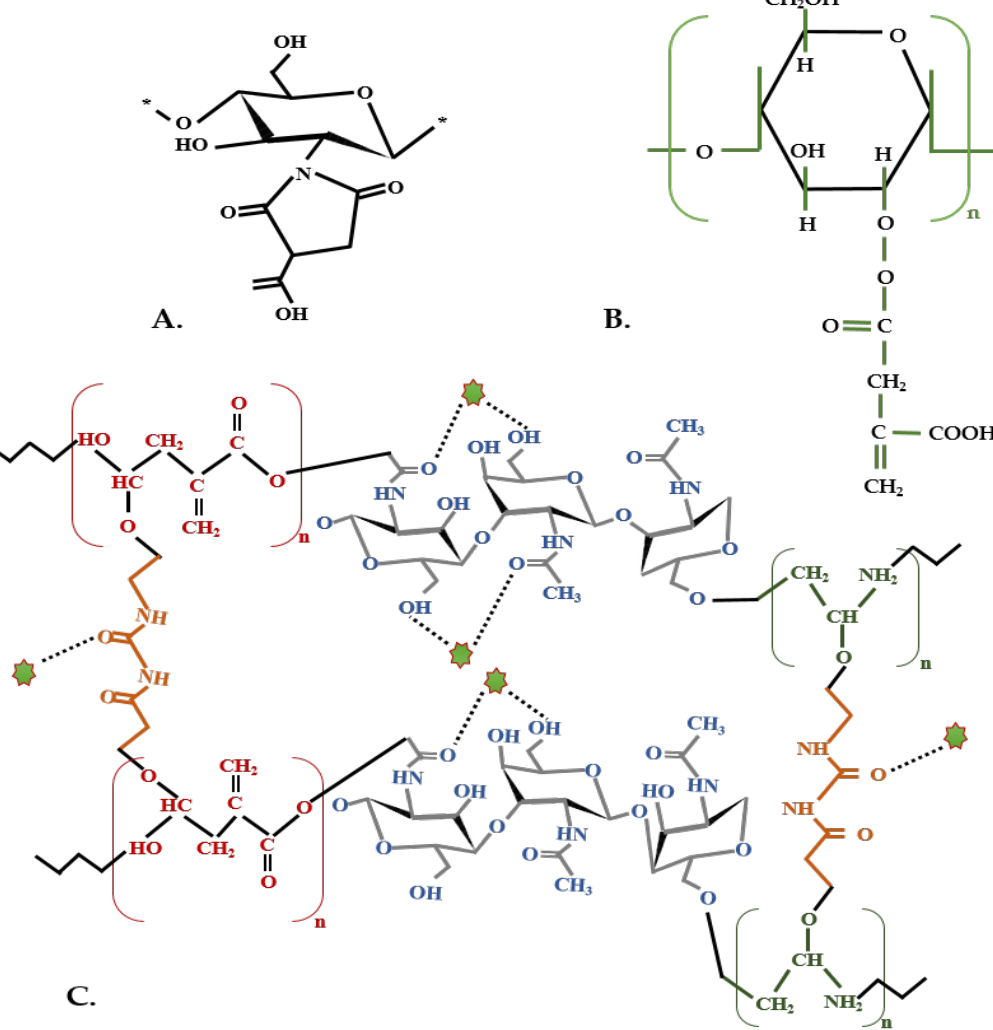
Figure 4. Biopolymers synthesized from IA for water treatment applicabilities ( A ). Modified chitosan with itaconic acid (adapted after [113]) ( B ). Guar gum grafted itaconic acid (adapted after [120]) ( C ). Chitin-cl-poly(IA-co-acrylamide)/zirconium tungstate, green stars represent ammonium persulphate (adapted after [121]).